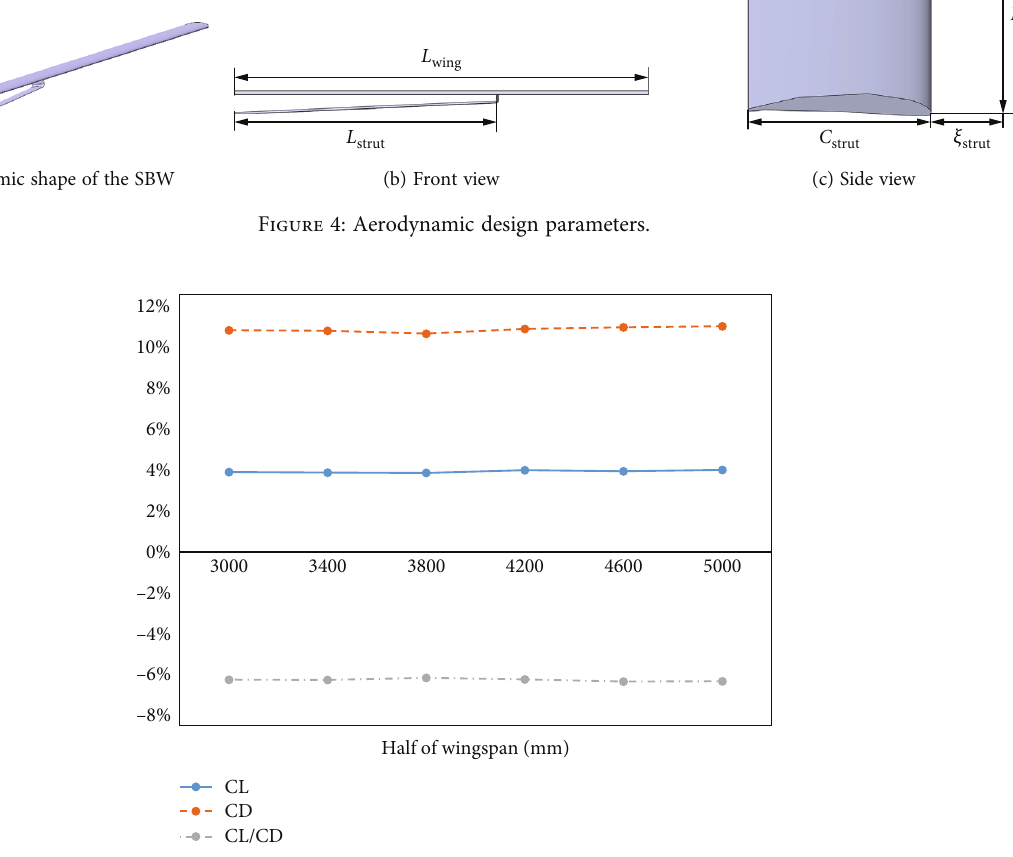
Figure 5: In fl uence of the wingspan on the lift-drag